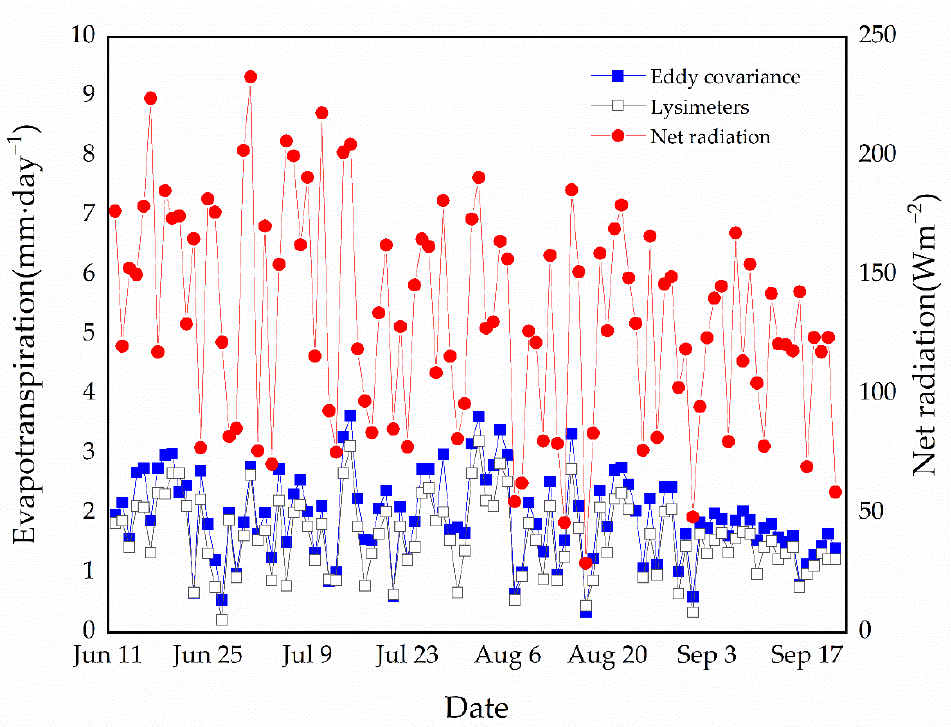
Figure 2. Evapotranspiration rates between eddy covariance technique for alpine meadow and lysimeter (intact herbs and moss) during the growing season in 2012. The blue line and solid squares represent daily average tundra evapotranspiration measured by the eddy covariance technique. The black line and hollow squares represent daily average evapotranspiration rates measured by lysimeters with intact graminoid and moss vegetation ( n = 9 lysimeters). The red line and solid circles represent the daily average alpine meadow net radiation, as measured by a radiometer on the eddy covariance tower.